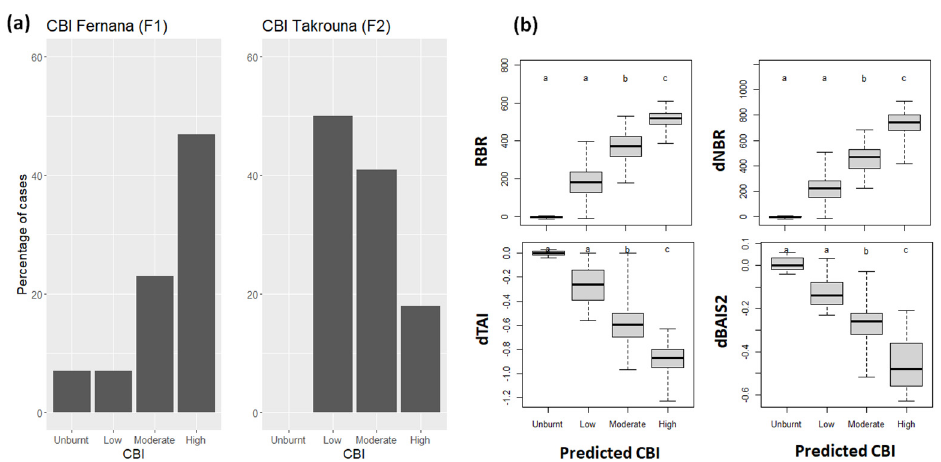
Figure 9. ( a ) Percentage of occupation of the predicted CBI classes from the spatialized CBI using the BRT: unburnt (CBI: 0–0.1), low severity (CBI: 0.1–1.24), moderate severity (CBI: 1.25–2.24), and high severity (CBI: 2.25–3) for both fires of Fernana (F1) and Takrouna (F2); and ( b ) boxplots of the different spectral severity indices in each CBI class merging both fires. Letters indicate the separability among CBI classes according to the post-hoc Kruskal–Wallis Dunn test.